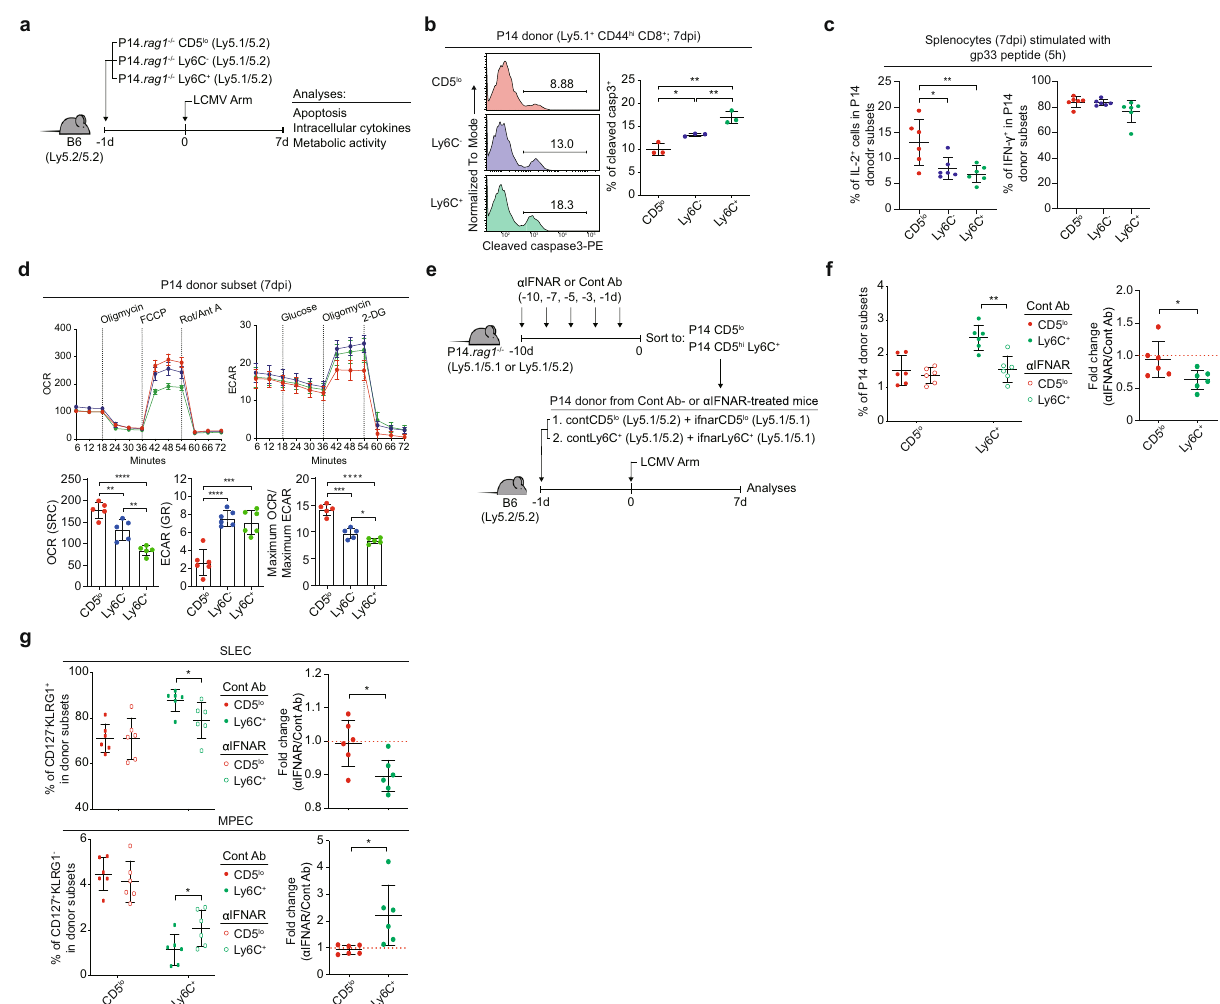
Fig. 7 Tonic type I IFN shapes the inherent ability of Ly6C + cells to acquire high SLEC but low MPEC skewing upon LCMV infection. a Experimental scheme of ( b – d ). b Percentage of cleaved caspase 3 + donor cells ( n = 3 mice for each group). c IL-2 (left) and IFN- γ (right) production of P14 CD44 hi donor cells (n = 6 mice for each group). d OCR and ECAR pro fi les of P14 CD44 hi donor cells ( n = 5 mice for OCR (SRC) and Maximum OCR/Maximum ECAR, n = 6 mice for ECAR (GR)). e Experimental scheme of ( f , g ) . f , g Percentage of P14 CD44 hi donor cells ( f ) and Percentage of CD127 − KLRG1 + or CD127 + KLRG1 − donor cells ( g ) previously treated with Control Ab or IFNAR Ab in vivo ( n = 6 mice for each group). Statistical signi fi cance was con fi rmed by two-tailed unpaired Student ’ s t -test. Results are shown as mean ± SD. Data representative of 2 – 3 independent experiments. Source data are provided